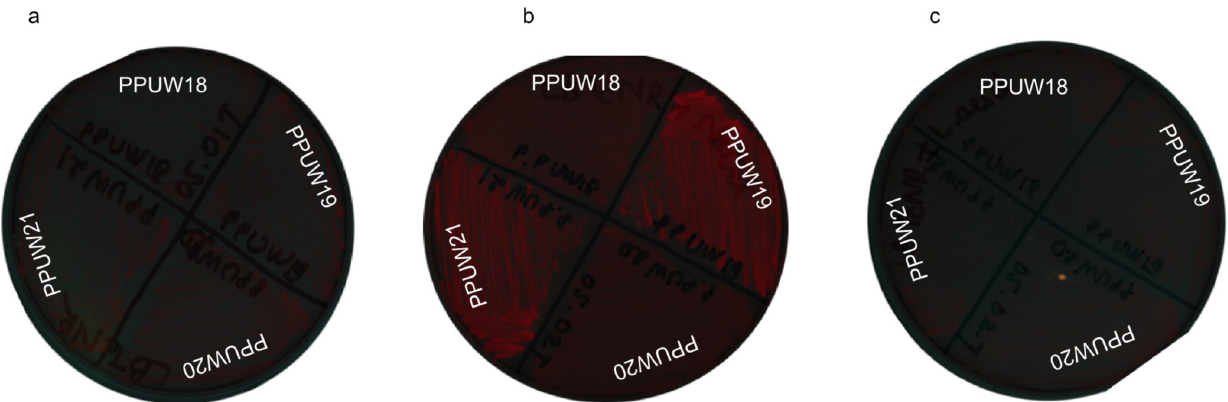
Fig 7. Fluorescence observation of different P . putida strain backgrounds on different PHA and non-PHA accumulating agar plates. PPUW18 ( phaC mutant harboring pTH1227), PPUW19 ( phaC mutant harboring pTAM), PPUW20 (wild-type KT2440 harboring pTH1227), PPUW21 (wild-type KT2440 harboring pTAM). a: LB + Nile Red, b: LB + sodium octanoate + Nile Red, c: LB + lactic acid + Nile Red.